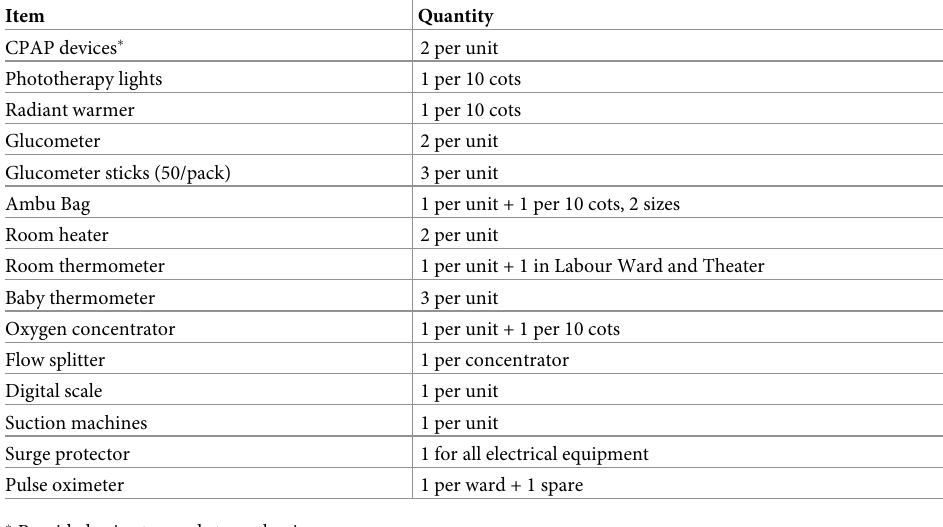
Table 1. Equipment bundle and quantity by number of beds provided for ward-strengthening program at dis- trict-level hospitals in Malawi (2017–2018). Item Quantity CPAP devices � 2 per unit Phototherapy lights 1 per 10 cots Radiant warmer 1 per 10 cots